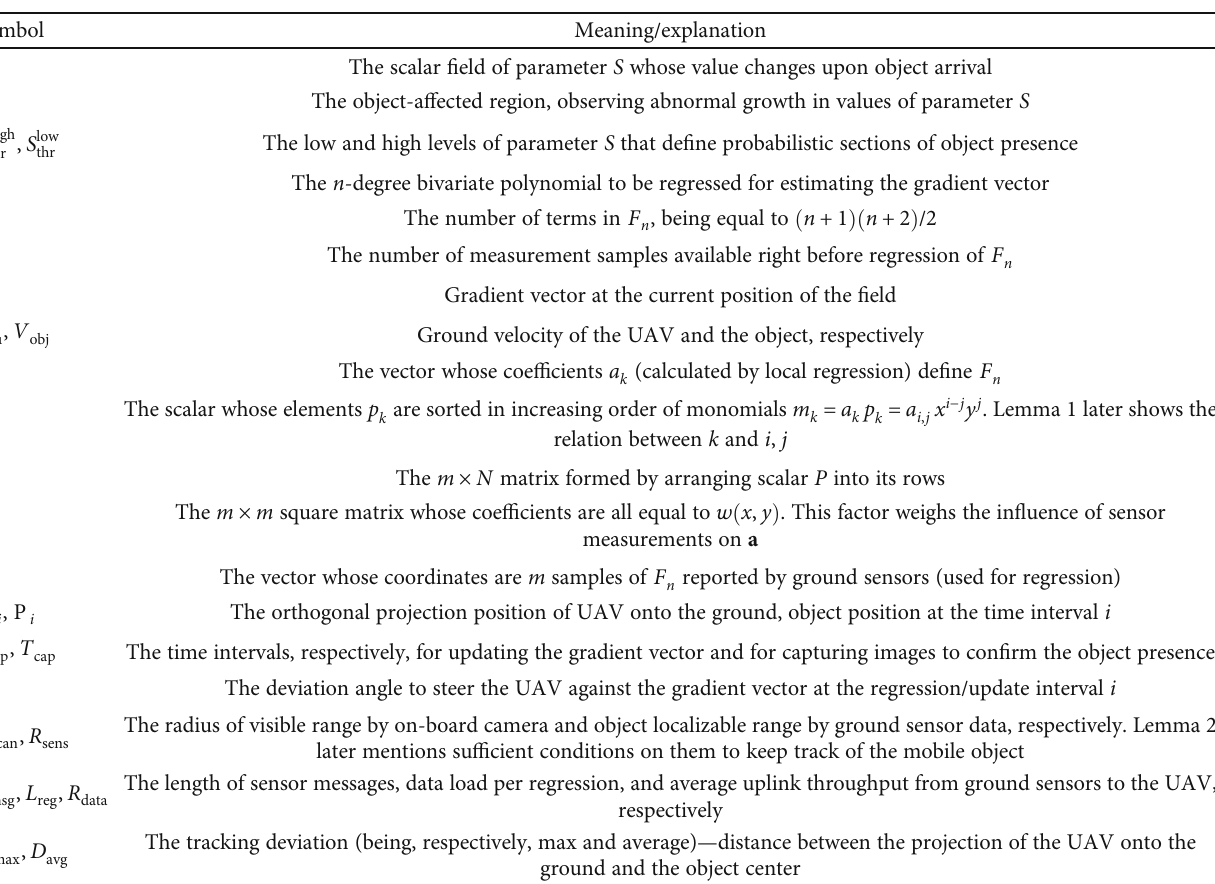
Table 1: De fi nition of key